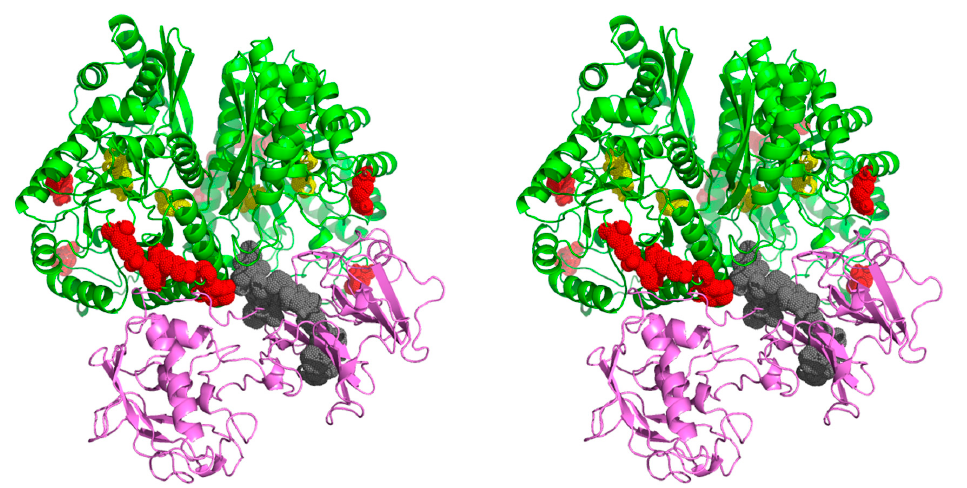
Figure 5. Proposed model of the interaction between C. albicans enolase (green) and human VTR (purple). The docking was performed for the C. albicans enolase dimeric structure (template PDB ID: 1EBH [58]) and VTR structure obtained based on multiple templates (PDB ID: 3C7X, 1OC0, 2JQ8 and 3BT1 [61–64]). The enolase peptides and the VTR peptide identified in the chemical mapping experiments are indicated in red and gray, respectively. The active site residues of the catalytic center of enolase are indicated in yellow. The 3D molecular model is presented in a wall-eyed stereo view. An additional file Enolase_VTR.mpg with the PyMOL-generated video presentation of this model is attached to the article together with the Supplementary Materials (Video S1).